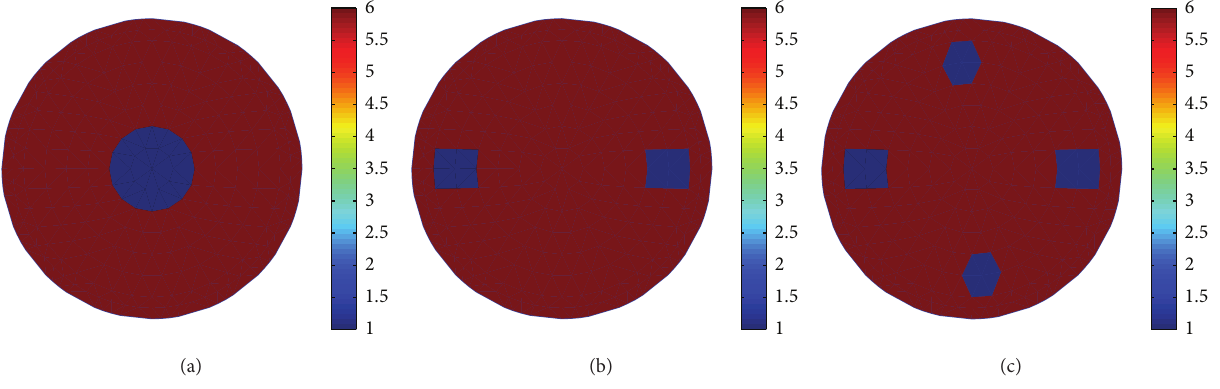
Figure 2: Three simulation